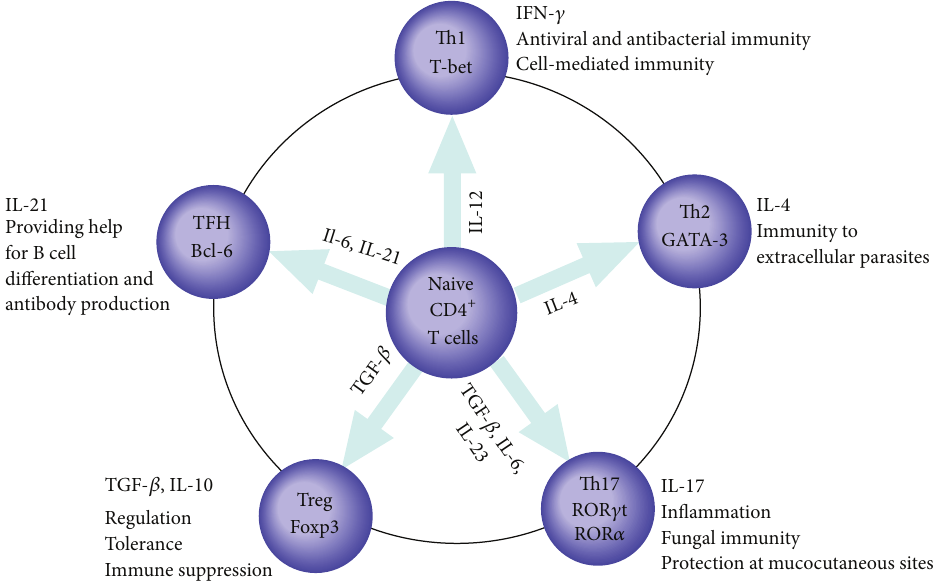
Figure 1: Effector subsets of CD4 + T cells: ontogenic and major cytokines, and roles in diseases. Naive CD4 + T cells differentiate into diverse effector subsets dependent on stimulatory cytokines in the microenvironment upon activation by pathogens. These stimulatory cytokines induce transcription factors expression of these subsets. IL-12 induces T-bet in the case of Th1 cells, IL-4 induces GATA3 in the case of Th2 cells, TGF- 𝛽 , IL-6, and IL-23 induce ROR 𝛾 t and ROR 𝛼 in the case of Th17 cells, TGF- 𝛽 induces Foxp3 in the case of Treg cells, and IL-6 and IL-21 induce Bcl-6 in the case of TFH cells. Subsequently, different effector subsets produce distinct cytokines and acquire specialized effector function. Th1 cells produce IFN- 𝛾 associated with antiviral and antibacterial immunity and cell-mediated immunity, Th2 cells produce IL-4 associated with immunity to extracellular parasites, Th17 cells produce IL-17 associated with inflammation, fungal immunity, and protection at mucocutaneous sites, Treg cells produce TGF- 𝛽 and IL-10 associated with regulation, tolerance, and immune suppression, and TFH cells produce IL-21 associated with providing help for B cell differentiation and antibody production. Bcl-6, B cell lymphoma 6; Foxp3, forkhead box p3; GATA-3, GATA-binding protein 3; IFN- 𝛾 , interferon- 𝛾 ; IL-4, interleukin 4; IL-6, interleukin 6; IL-10, interleukin 10; IL-12, interleukin 12;IL-17,interleukin17;IL-21,interleukin21;IL-23,interleukin23;ROR 𝛾 t,retinoid-relatedorphanreceptor 𝛾 t;ROR 𝛼 ,retinoid-relatedorphan receptor 𝛼 ; T-bet, T-box transcription factor; TGF- 𝛽 , transforming growth factor- 𝛽 ; TNF, tumour necrosis factor; Treg, T